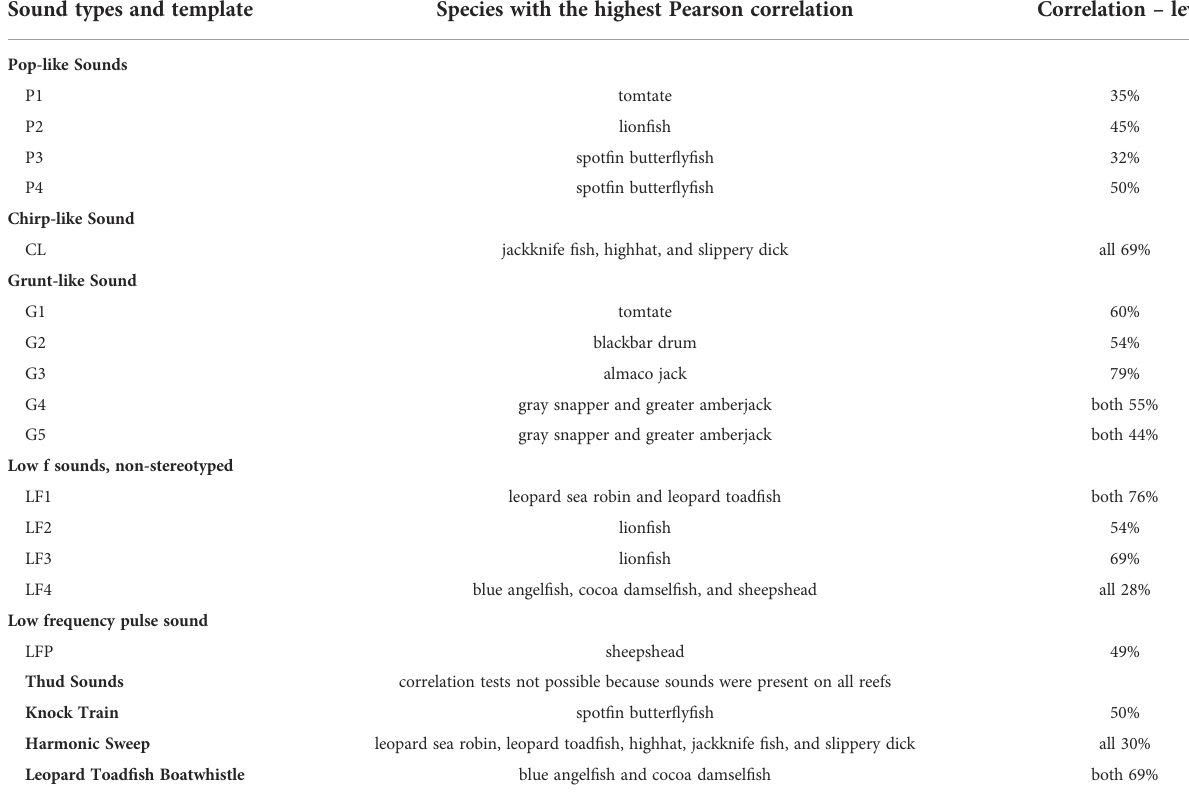
TABLE 4 Associations between sound types among reefs and species presence (Pearson correlation). Sound types and